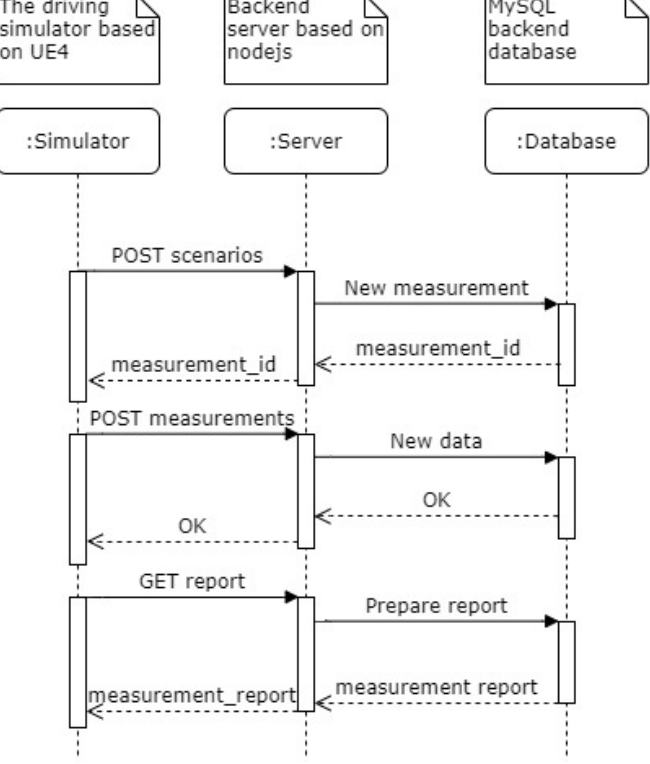
Figure 7. The flow diagram of the REST calls.